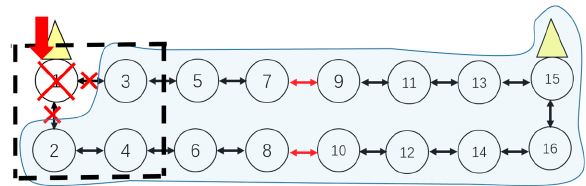
Figure 8. Cluster head failed.